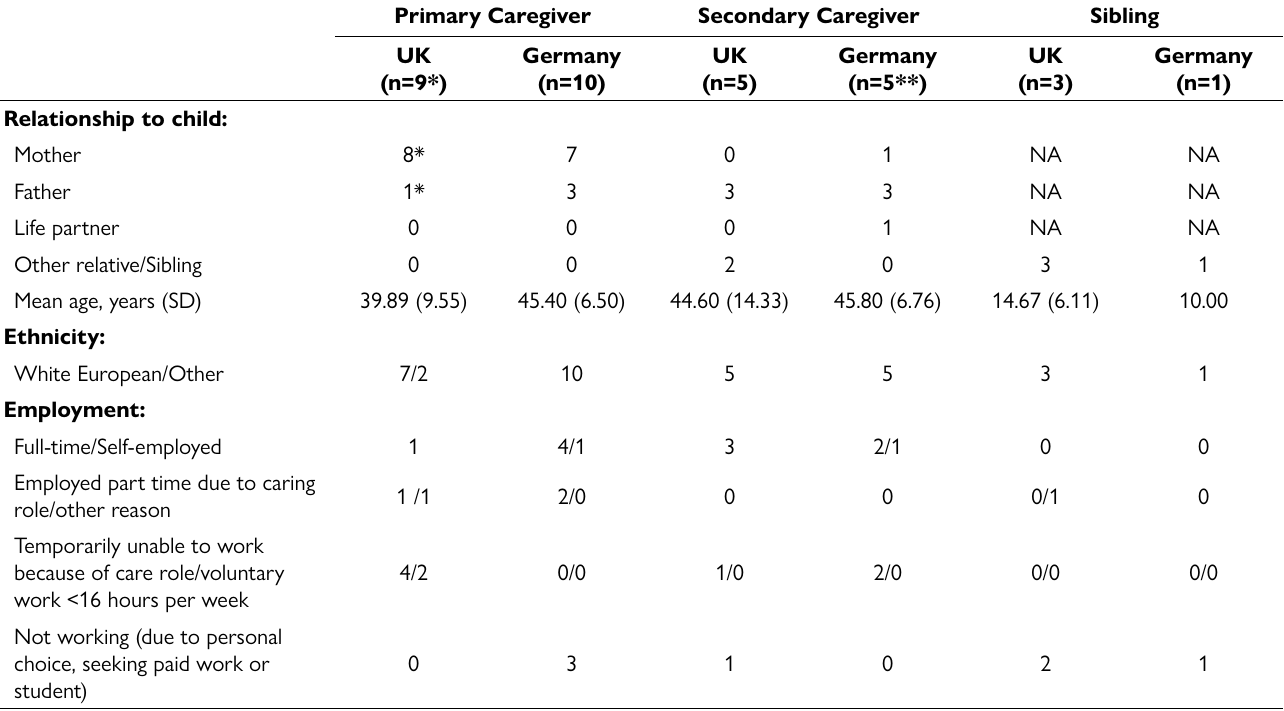
Table 3. Demographic details of family